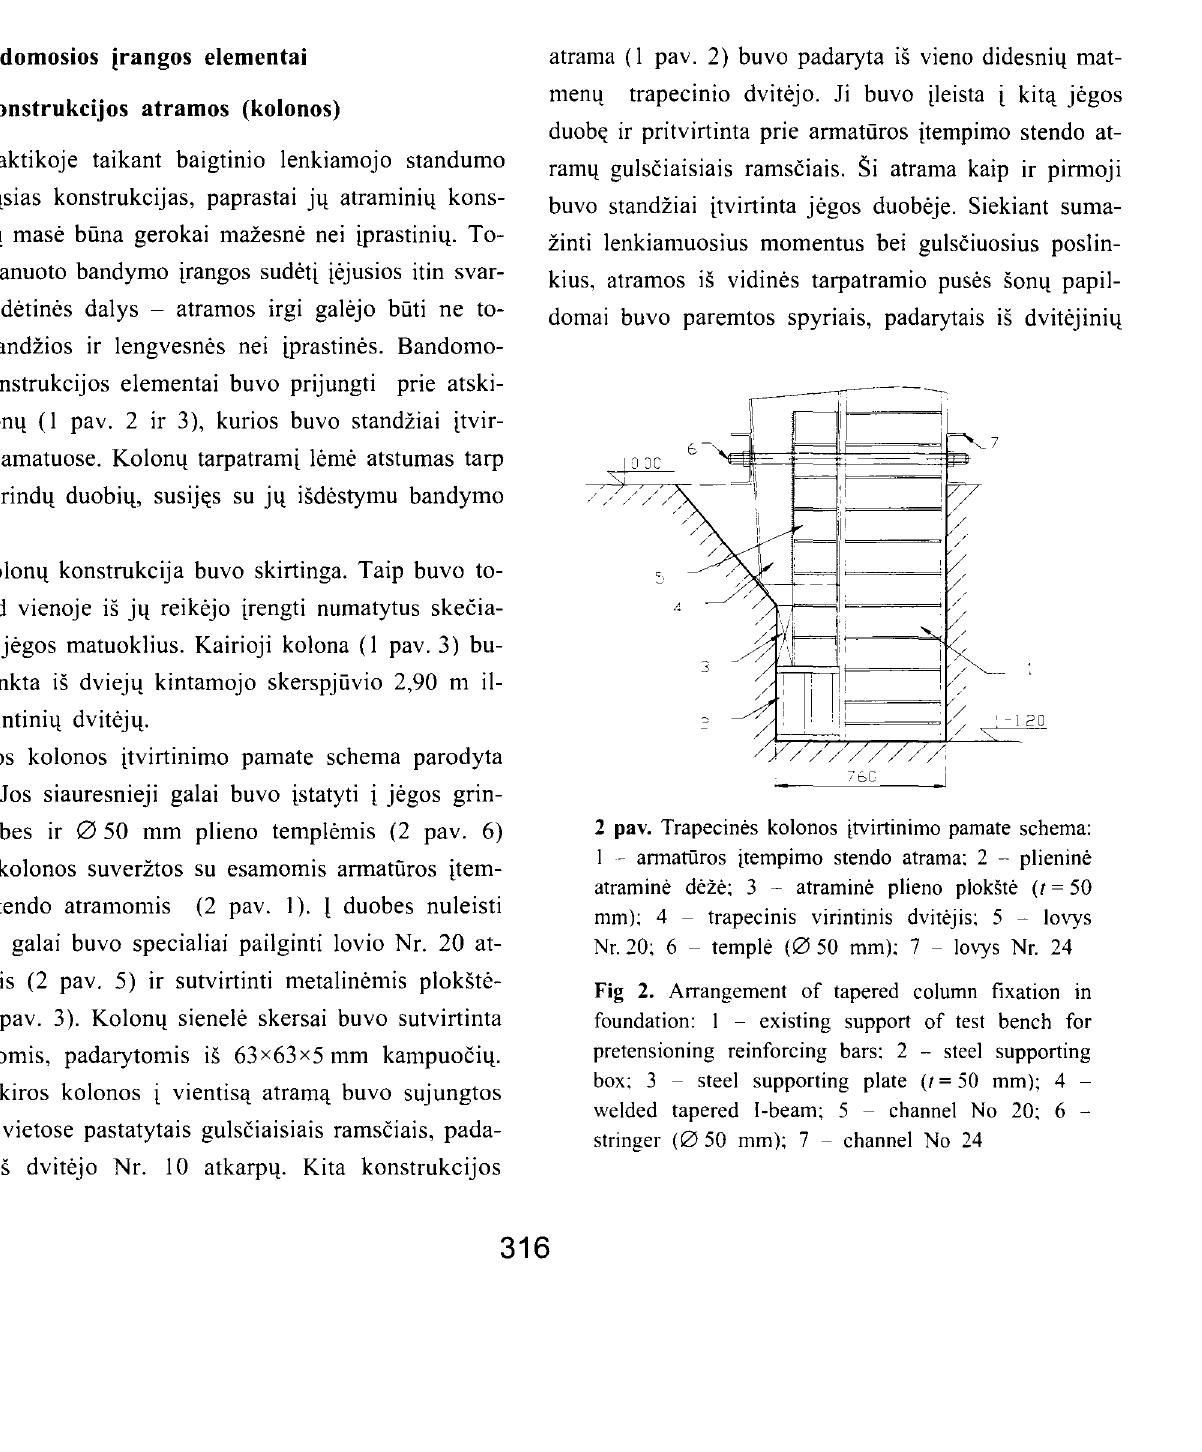
Fig 1. Test arrangement: I - experimental member: 2 - compact tapered support: 3 - built-up twin tapered support: 4 - Boatswain's loading chair: 5 - cable: 6 - brace strut: 7 - existing supports of steel reinforcement pretensioning